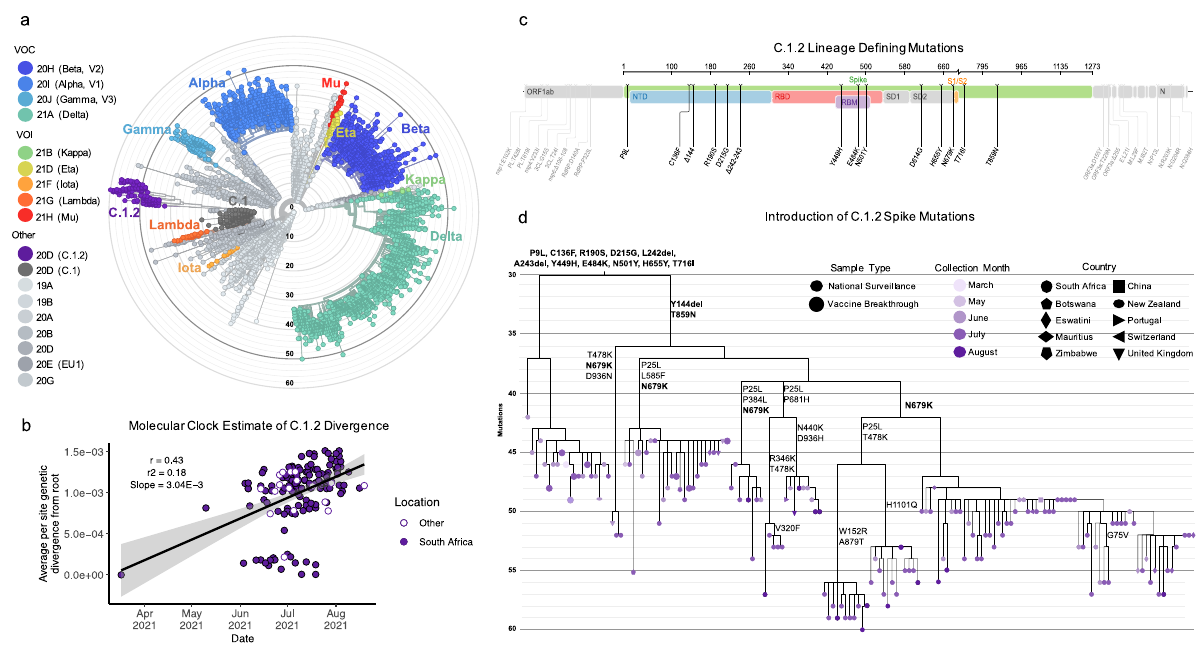
Fig. 1 C.1.2 a highly mutated SARS-CoV-2 variant. a Phylogenetic tree of 6,192 global sequences (1,991 sequences from South Africa), including variants of concern (VOC), variants of interest (VOI), and the C.1.2 lineage, colored by Nextstrain clade (shown in the key; VOCs and VOIs are in color, other clades in greyscale) and scaled by divergence (number of mutations). The C.1.2 lineage (purple) forms a distinct, highly mutated cluster within clade 20D. b Regression of root-to-tip genetic distances against sampling dates for sequences belonging to lineage C.1.2 sampled either in South Africa (solid purple) or in other countries (white) indicating that the C.1.2 sequences evolved in a clock-like manner (correlation coef fi cient = 0.43, R 2 = 0.18). The regression gradient is an estimate of the rate of sequence evolution, which is 3.04 × 10 − 3 nucleotide substitutions/site/year. Regression lines are shown with error buffers (shaded area) representing 90% con fi dence intervals. c Full genome representation of C.1.2 showing lineage de fi ning mutations (seen in ≥ 50% of C.1.2 assigned sequences), with those in the spike (green) colored according to functional regions, including the N-terminal domain (NTD, blue), receptor binding domain (RBD, red), receptor binding motif (RBM, purple), subdomain 1 and 2 (SD1 or SD2, gray) and the cleavage site (S1/S2, yellow). Figure generated by covdb.stanford.edu. d A phylogenetic tree highlighting the introduction of spike mutations in the different sub-clades of the C.1.2 lineage. The tree is colored by month of collection, with tip symbols indicating country of collection, as indicated in the key (Figure generated from a Nextstrain build of global C.1.2 sequences with ≥ 90% coverage). Mutations in bold represent those observed in ≥ 50% of the C.1.2